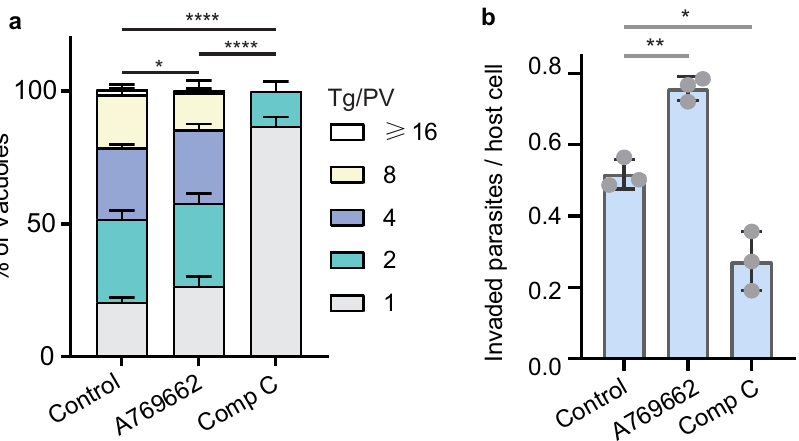
Fig. 6 | Effects of the AMPK activator A769662 and inhibitor compound C (Comp C) on parasite replication and invasion. a intracellular replication assays of RHinthepresenceofindicatedtreatments,asdoneinFig.2d.Invadedparasites were allowed to replicate for 24h in MEF cells lacking both AMPK α 1 and AMPK α 2. Means±SEM of n =3 independent experiments, ****P <0.0001, *P =0.0201, two- way ANOVA with Tukey ’ s multiple comparisons post-tests. b ef fi ciency of host cell invasion determined by a two-color assay that discriminated invaded vs non- invaded parasites. The RH parasites were treated with indicated chemicals for 1h